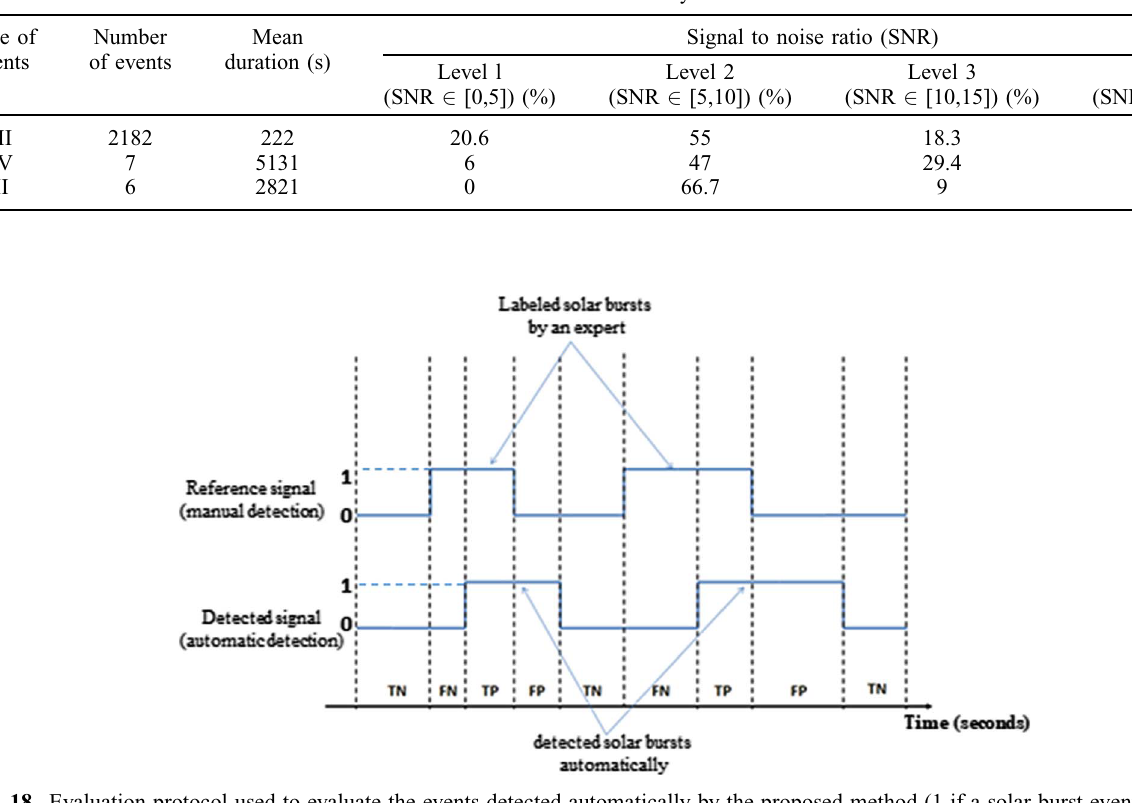
Fig. 18. Evaluation protocol used to evaluate the events detected automatically by the proposed method (1 if a solar burst event is detected and 0 if no).